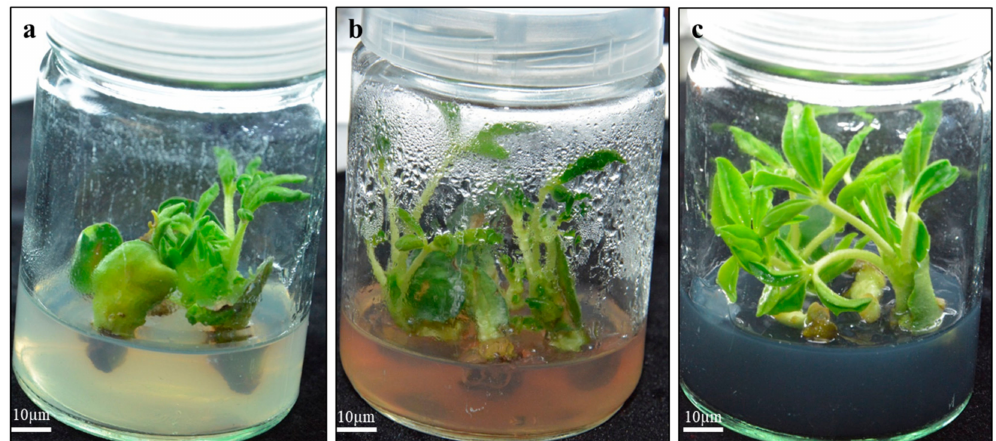
Figure 5. E ff ect of phenolic secretion on regeneration e ffi ciency of explants. ( a ) HCN cultured on shoot induction medium. ( b ) After 2 weeks of culturing media turning into brown color due to the antioxidant secretion, ( c ) activated charcoal 0.25 g L − 1 was added into the shoot elongation medium and successfully inhibited tissue browning.